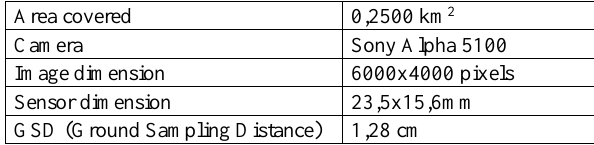
Table 2. Main characteristics of the multi-rotors flight